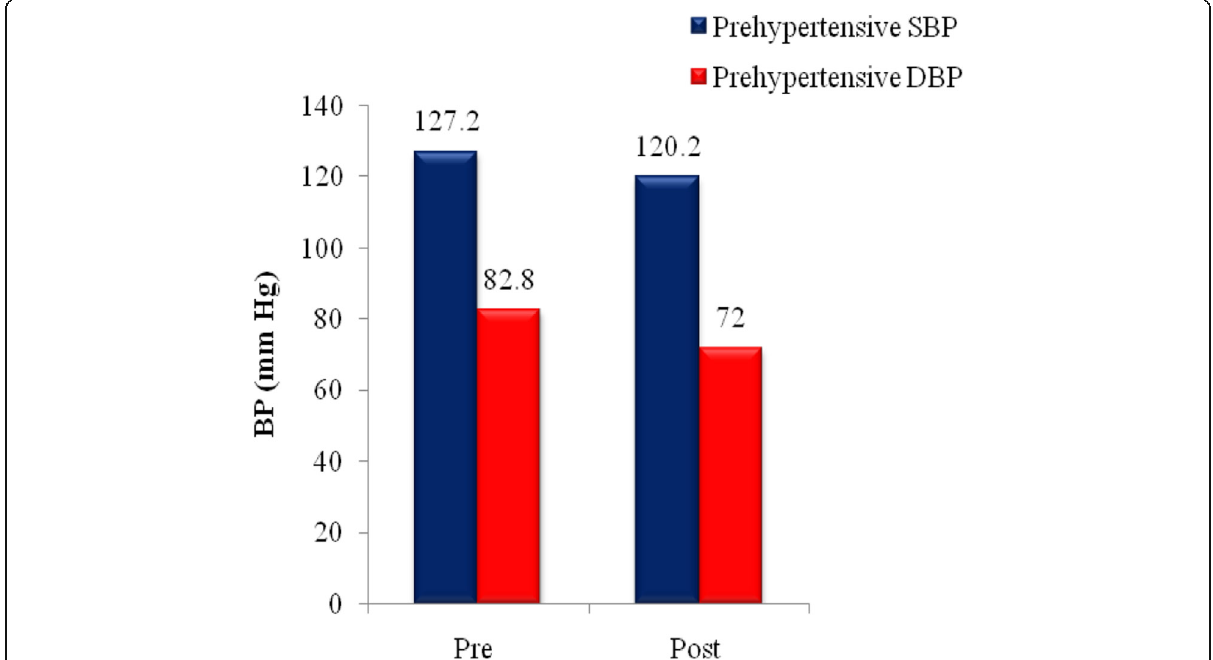
Fig. 2 Pre- and post-comparison of SBP and DBP in pre-hypertensive group in gradient exercise testing. Abbreviations : SBP systolic blood